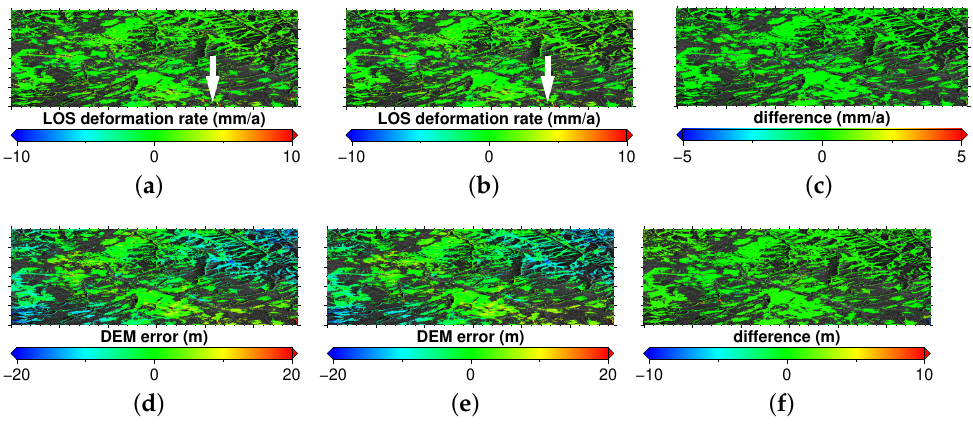
Figure 7. The annual deformation rate/DEM error maps obtained based on the EVD results ( a , d ) and the CPPCA results ( b , e ). The corresponding difference maps are presented in ( c , f